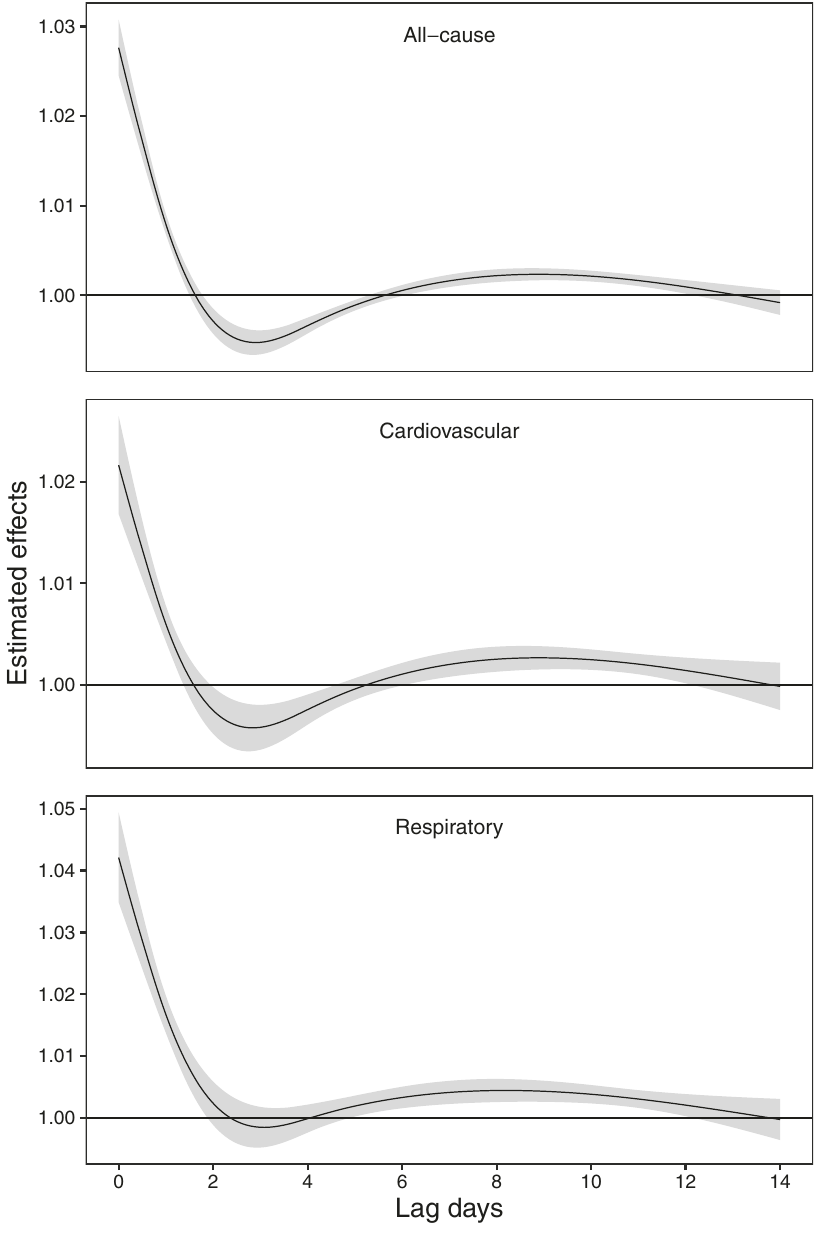
Fig. 2 | The association between wild fi re-related PM 2.5 exposure (every 10 μ g/ m 3 increase in wild fi re-related PM 2.5 ) and all-cause, cardiovascular, and respiratory mortalities across 0 – 14 lag days. (Note 1: The solid lines denote